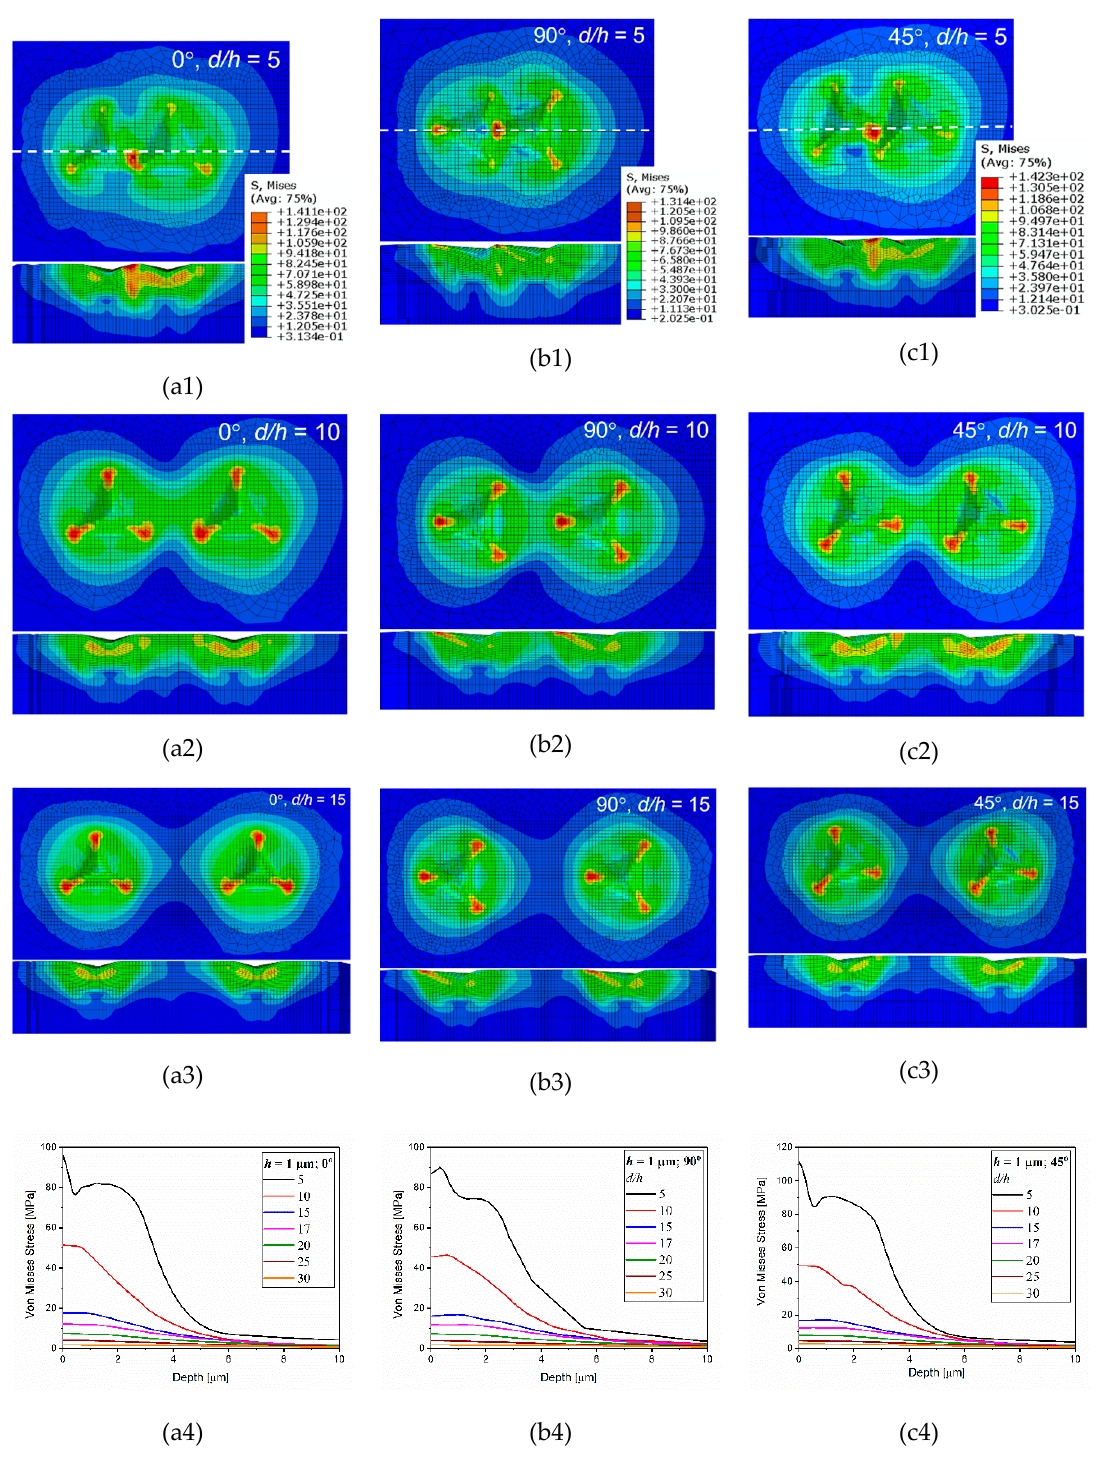
Figure 10. Von Mises stress [MPa] distributions for h = 1 µm with different orientations and different nominal separations. ( a ) 0°, ( b ) 90°, and ( c ) 45°; ( 1 ) d/h = 5, ( 2 ) d/h = 10, ( 3 ) d/h = 15, and ( 4 ) von Misses stress vs. depth taken from the finite element modelling cross-section at the center between two indents.